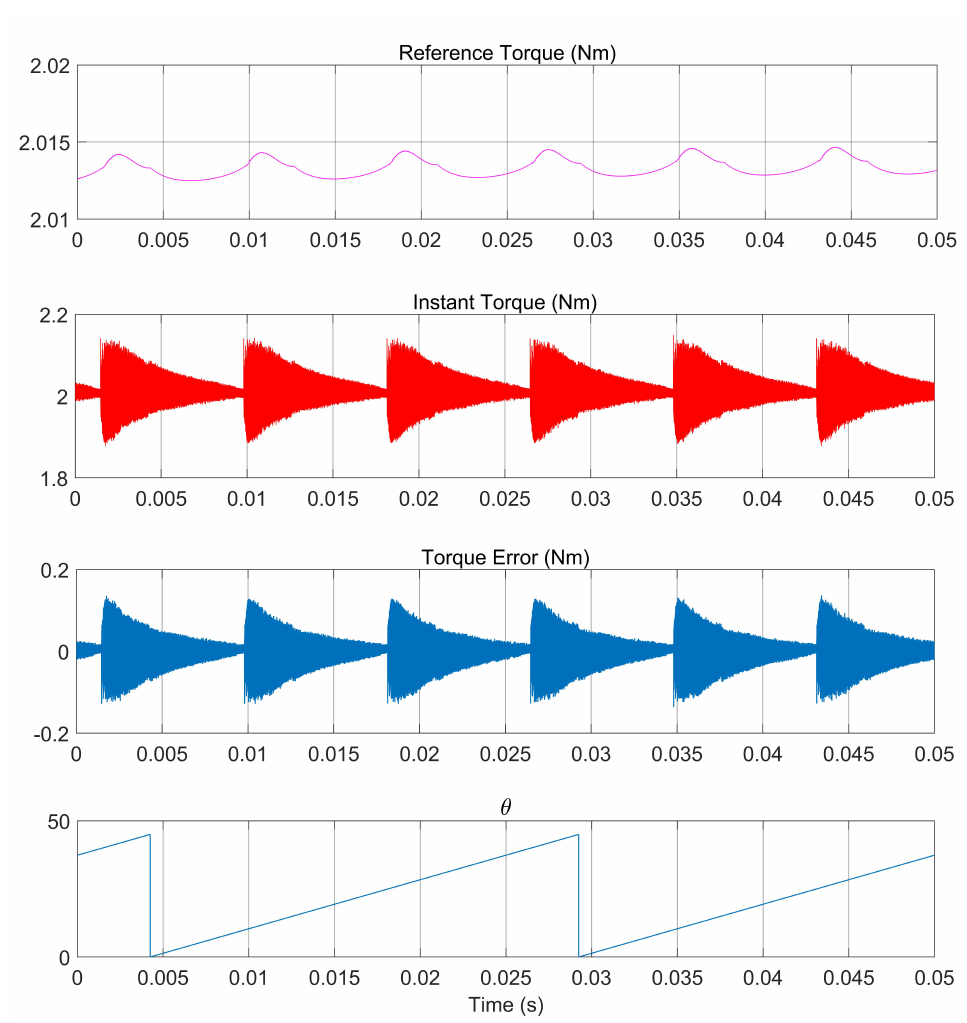
Figure 5. Curves of reference torque and instantaneous torque. 3.2. RTNN RTNN is used in the system to fine-tune the reference torque online according to the rotor angle. The working principle of RTNN is shown in Figure 6.